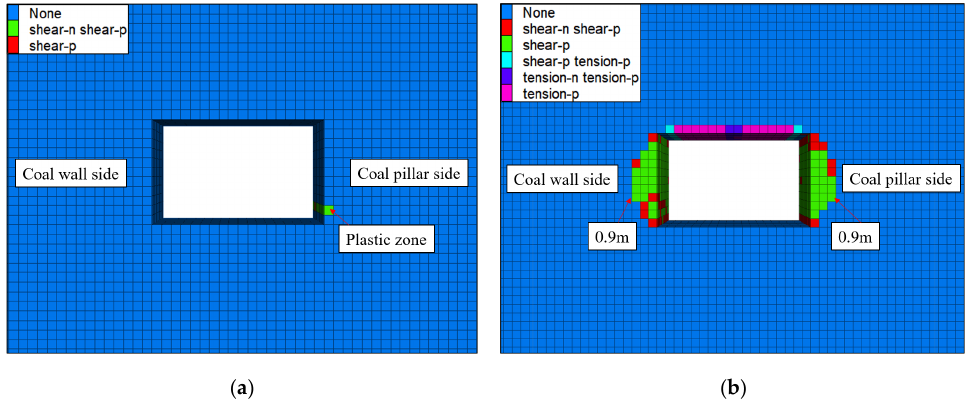
Figure 10. Development of plastic zone in surrounding rock: ( a ) primary mining influence; ( b ) secondary mining influence. ( b ) secondary mining